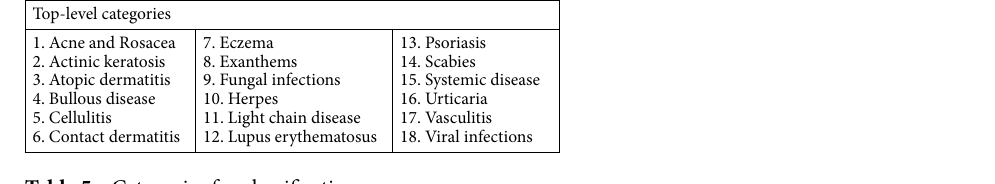
Table 5. Categories for classification.